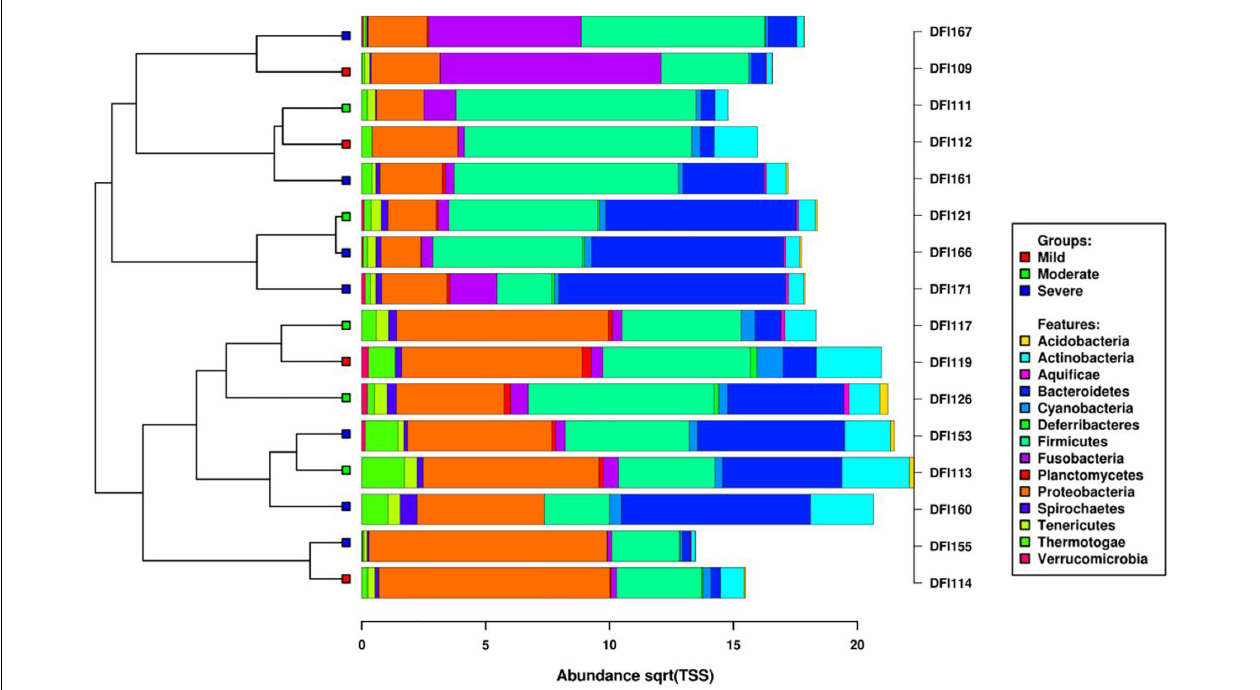
FIGURE 2 | Clustered bar chart based on hierarchical clustering of the Bray–Curtis distances of the DFIs based on the taxonomic composition of active bacterial phyla as determined by metatranscriptome sequencing predicted using Kraken and visualized in Calypso. The horizontal axis is the square root abundances of the identified